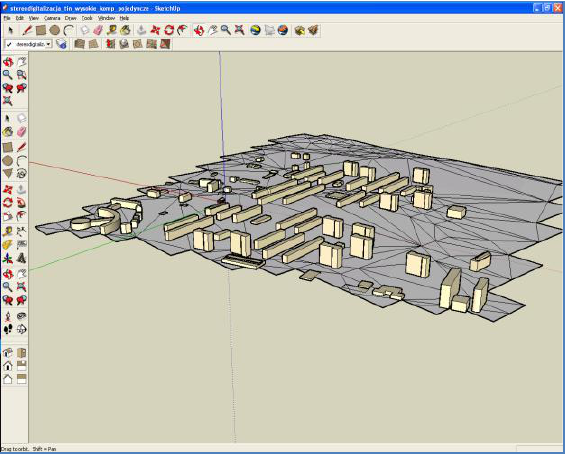
Fig. 7 3D models of buildings on the generated DTM